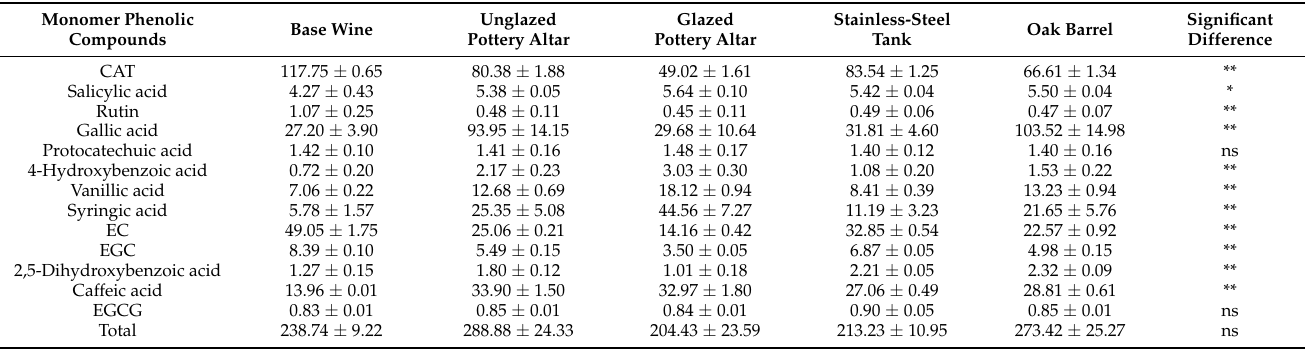
Monomer Phenolic Compounds Base Wine